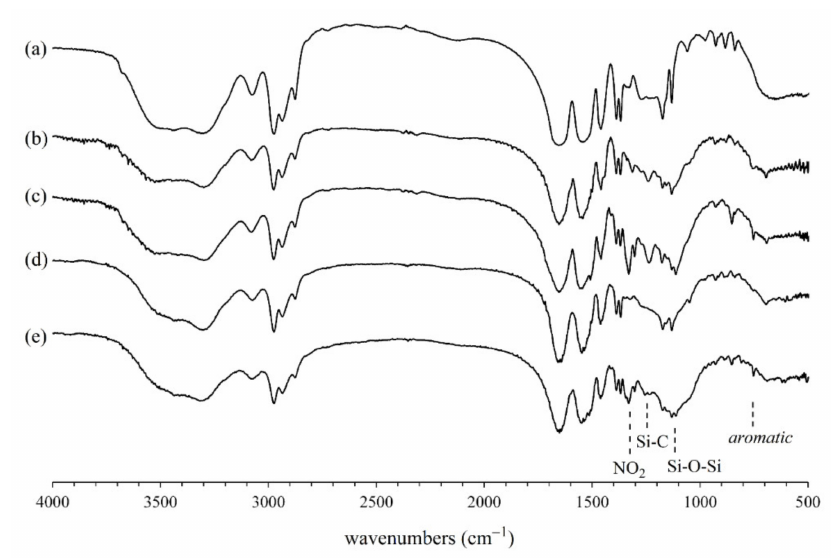
Figure 3. IR spectra of ( a ) G NIPAM (Table 2, run 1), ( b ) IPN 1a(0.2) (run 3), ( c ) IPN 1b(0.2) (run 6), ( d ) IPN 2a(0.2) (run 8), and ( e ) IPN 2b(0.2) (run 10) (KBr).